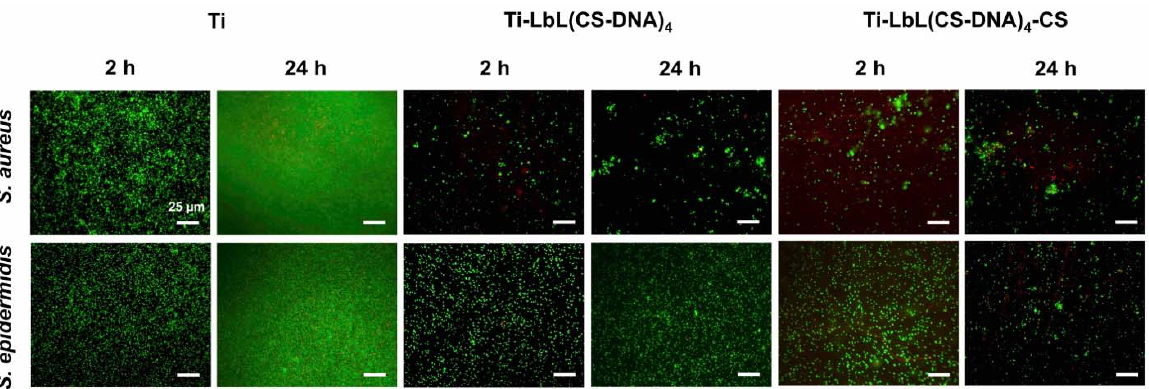
Figure 6. Representative fluorescence microscope images of adherent S. aureus ATCC 12598 and S. epidermidis ATCC 35984 on Ti, Ti-LbL(CS-DNA) 4 , and Ti-LbL(CS-DNA) 4 -CS surfaces after incubation at 37 ◦ C for 2 h and 24 h, respectively. Bacteria were stained using vitality staining solution (3.34 mM SYTO 9 and 20 mM propidium iodide in PBS) and were incubated for 15 min in the dark at room temperature. The scale bar denotes 25 µ